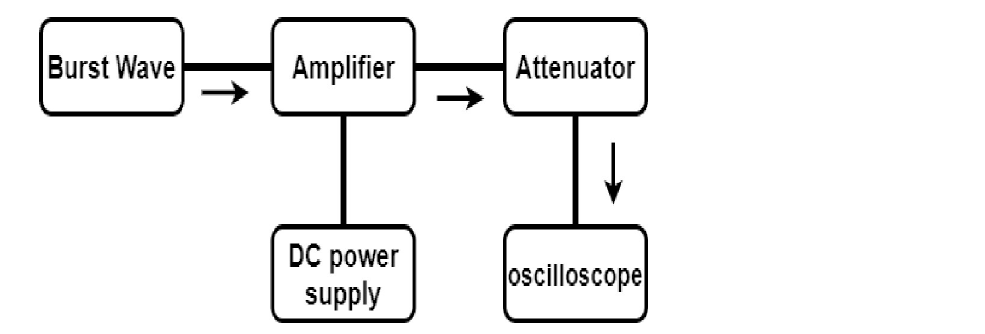
Fig 9. Block diagram showing amplifier performance measurement.